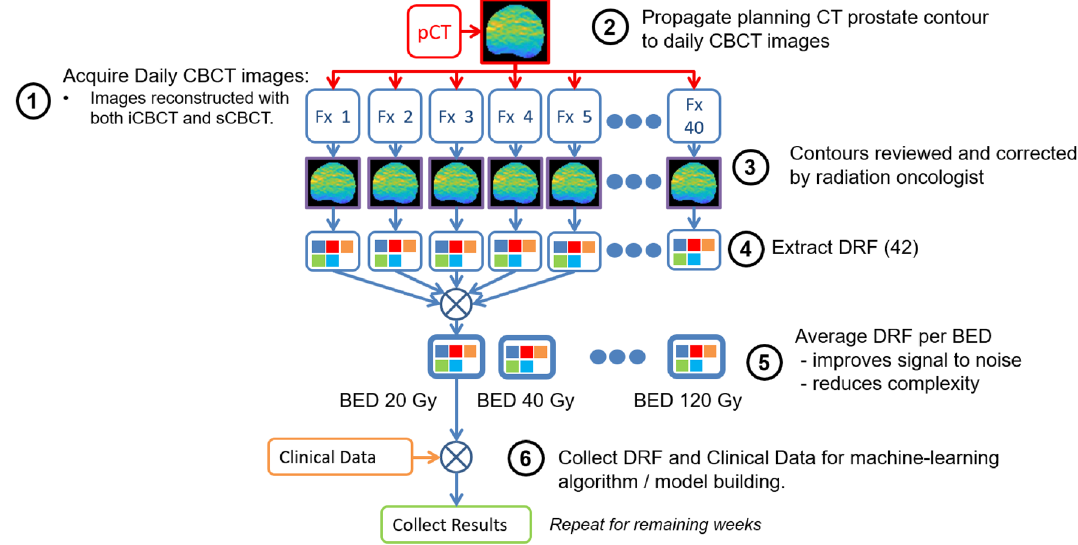
Figure 1. Extraction of delta-radiomic features ( DRF) from prostate daily CBCT images for analysis and model building.